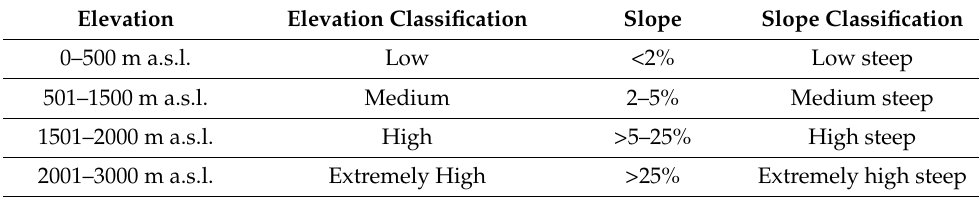
Table 6. Classification of sites regarding elevation and